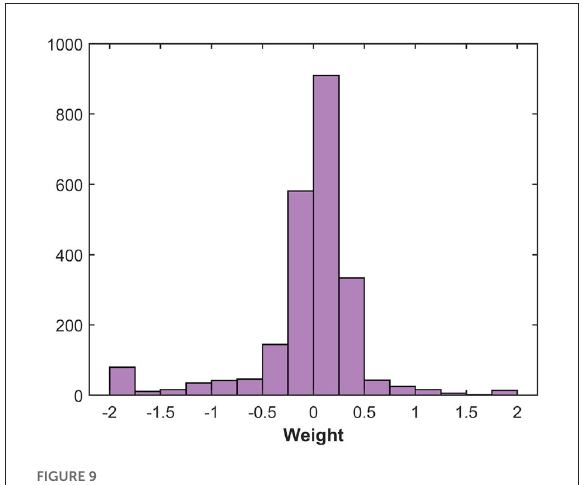
FIGURE9 Histogram of the weight